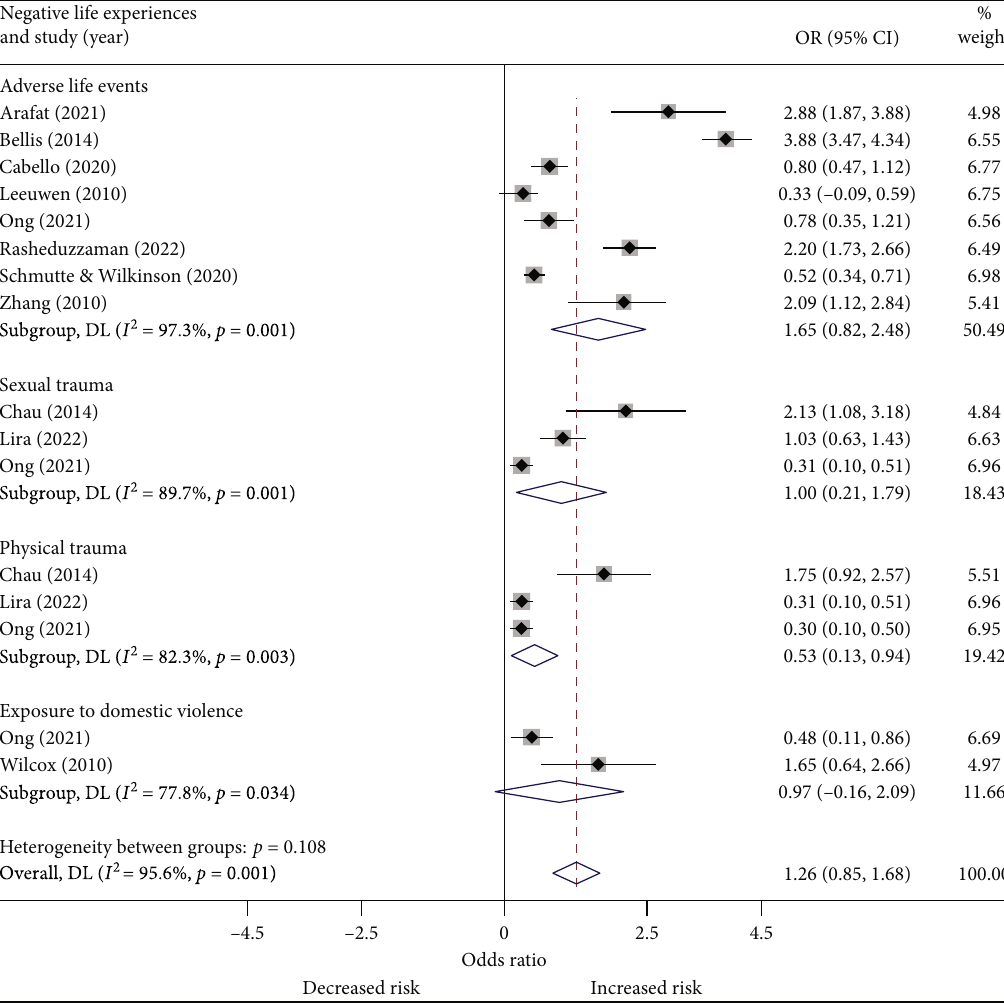
Figure 6: Negative life experiences as risk factors for suicide. Risk factors in this domain that are most strongly associated with suicide are adverse life events and sexual